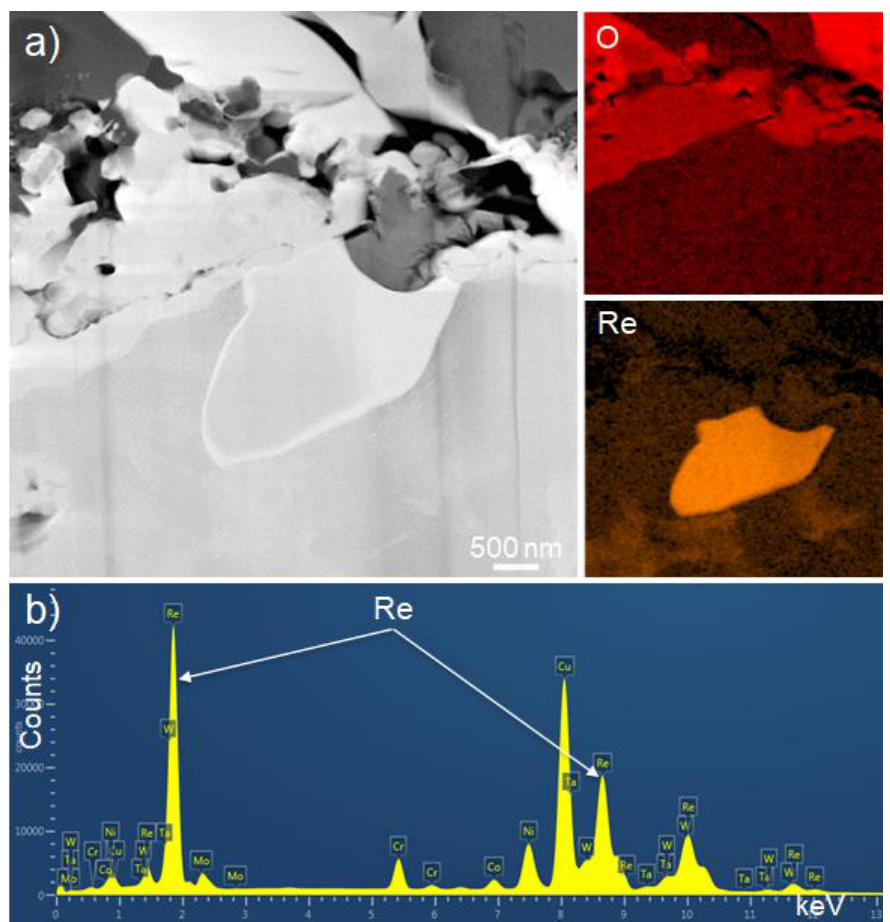
Figure 7. A STEM image and corresponding STEM-EDX element maps of oxygen and rhenium ( a ) and STEM-EDX point analysis on the bright particle in ( a , b ). and STEM-EDX point analysis on the bright particle in ( a , b